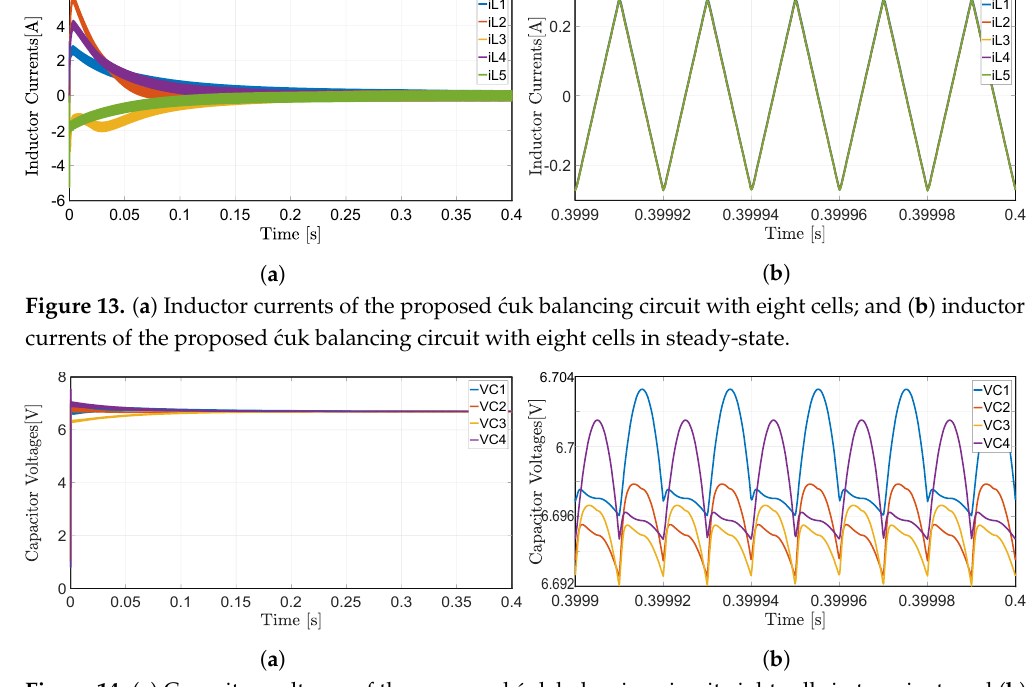
Figure 14. ( a ) Capacitor voltages of the proposed ´cuk balancing circuit eight cells in transient; and ( b ) capacitor voltages of the proposed ´cuk balancing circuit with eight cells in steady-state.